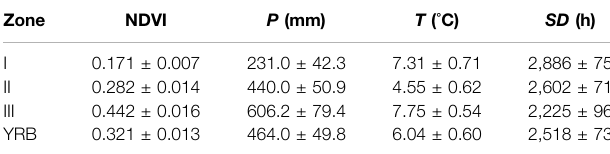
TABLE 1 | Statistics of annual NDVI and important climate variables during 1982 – 2015 in the Yellow River